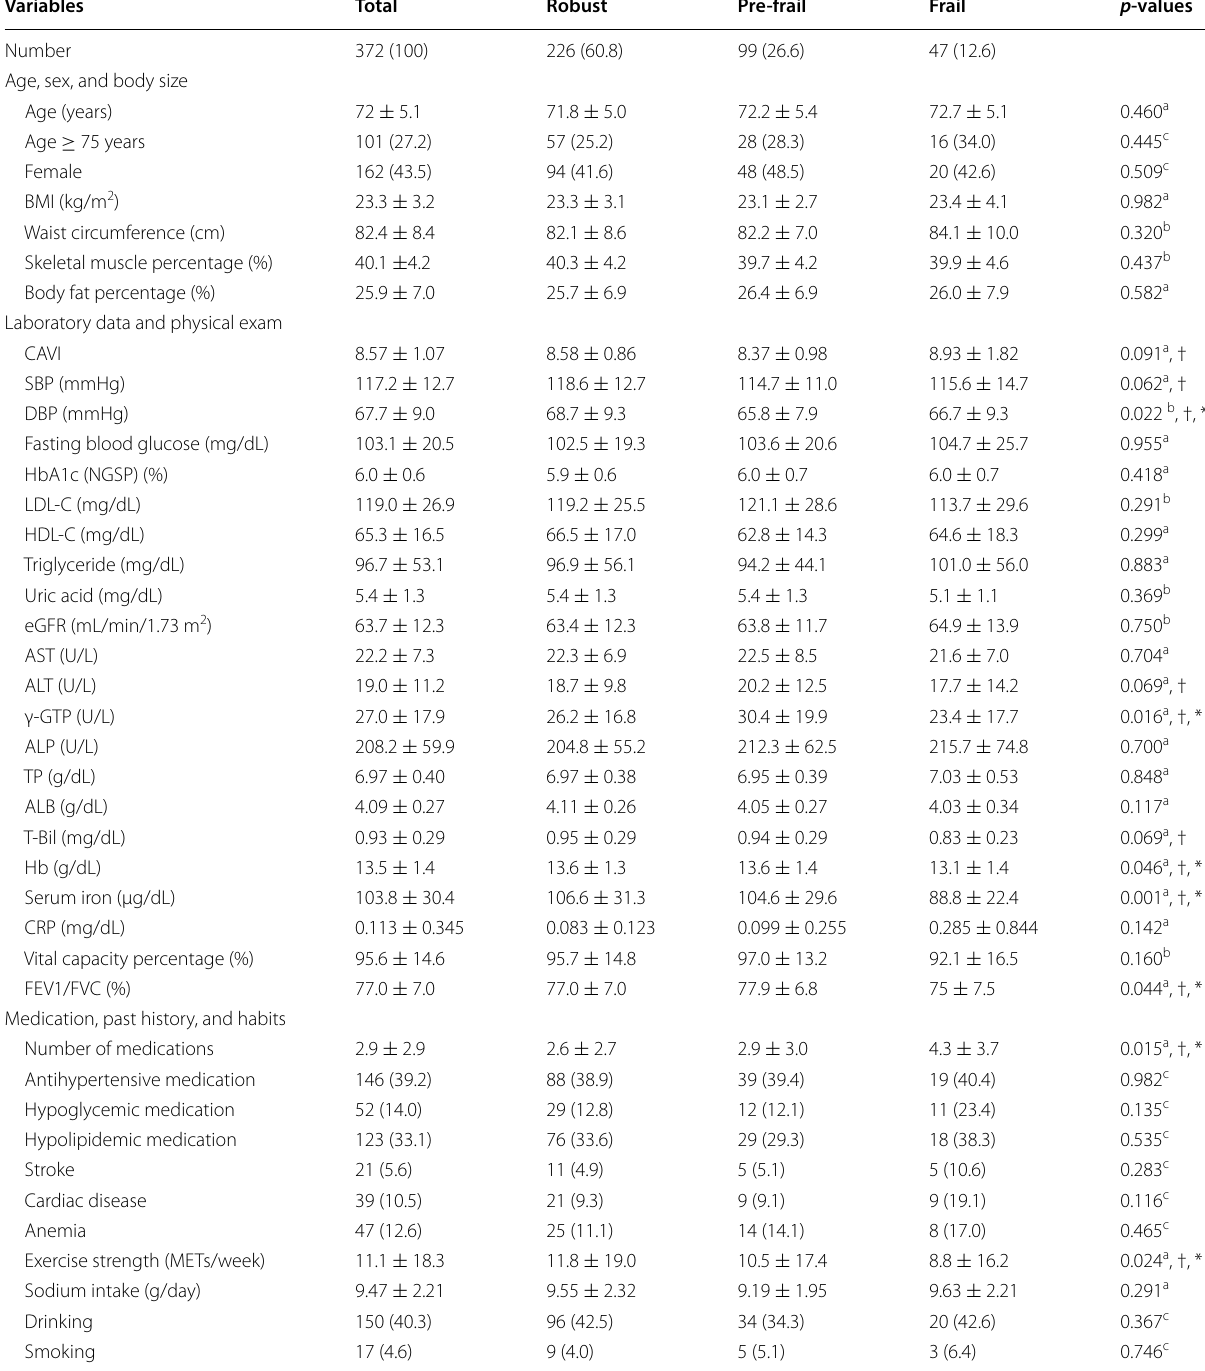
Numerical data are shown as mean